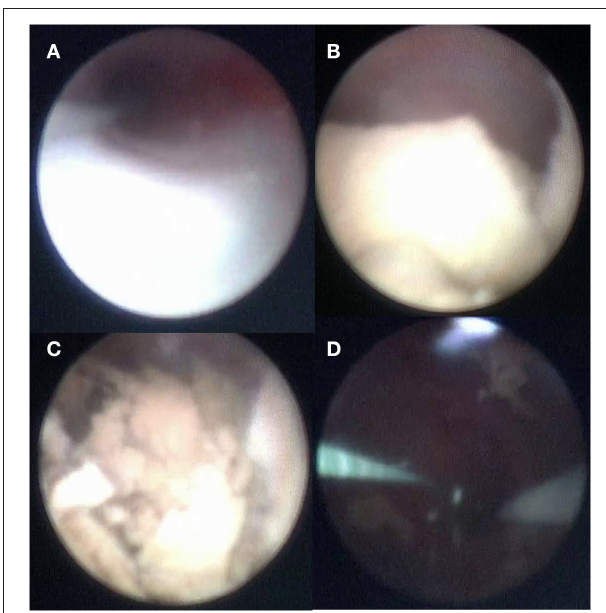
FIGURE 3 | Microureteroscopy in patient 2. (A) Ureteroscopy. (B) Renal pelvis lithiasis. (C) Lithotripsy with Ho: YAG Laser. (D) Renal pelvis without lithiasis after